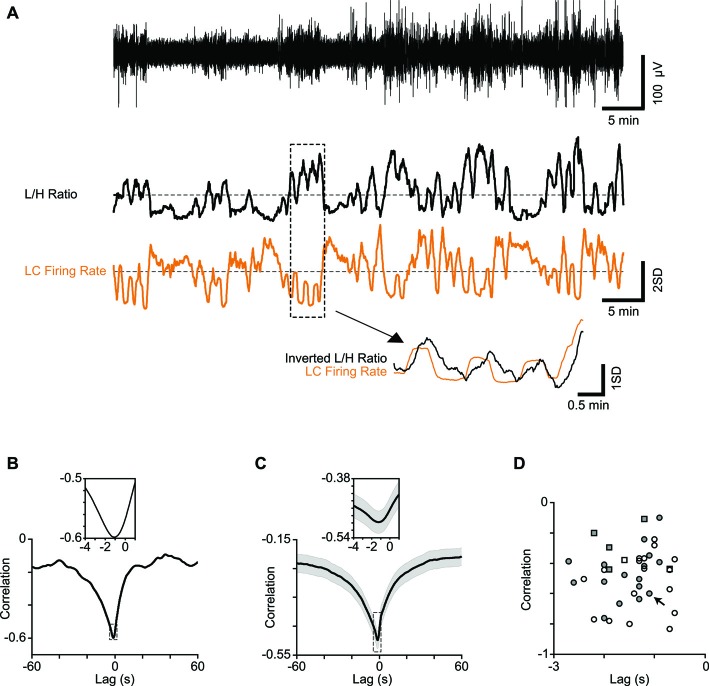
Correlation between LC firing rate and cortical state. (A) One-hour low-pass filtered EEG from a typical recording session (upper trace) and the corresponding L/H ratio (middle trace) aligned with the simultaneously recorded LC firing rate (orange). Both traces are z-scored. Four minutes of recording are magnified below to illustrate the temporal relation in more detail. Note the L/H ratio is inverted in the magnified trace to better visualize the relative timings. (B) Cross-correlation of a representative session in (A) shows maximum correlation at −1.1 s. The inset shows a 5-s window around maximum correlation. (C) Average cross correlation across 34 sessions (multi-units). The inset shows a 5-s window around maximum correlation. (D) Every dot represents one session. Squares represent single-units and circles represent multi-units. Filled symbols show units for which the electrode position in LC was histologically confirmed. The arrow shows the sample session in (A) and (B).